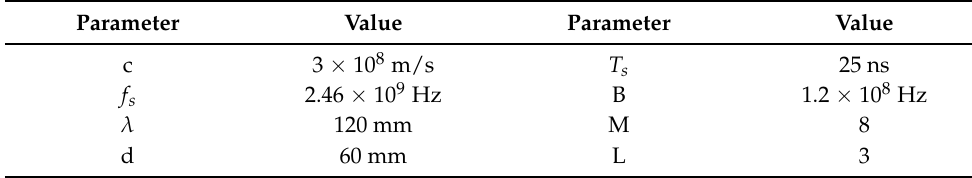
Table 2. Parameters of the FMCW-MIMO radar.